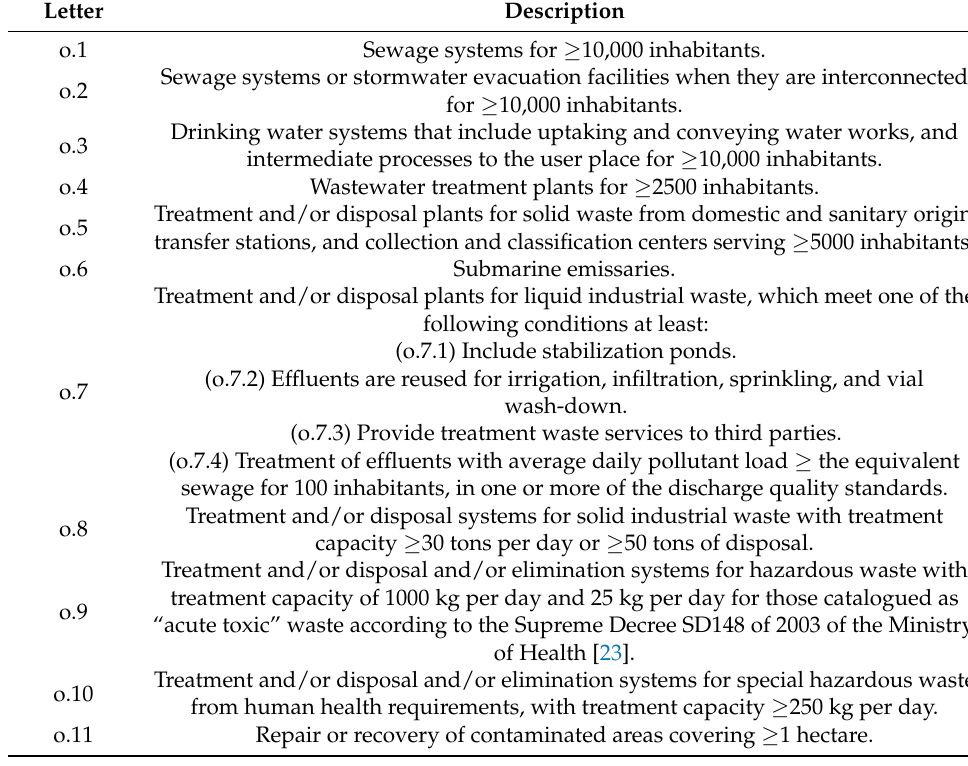
Table 1. Description of the sanitation projects subjected to EIA in